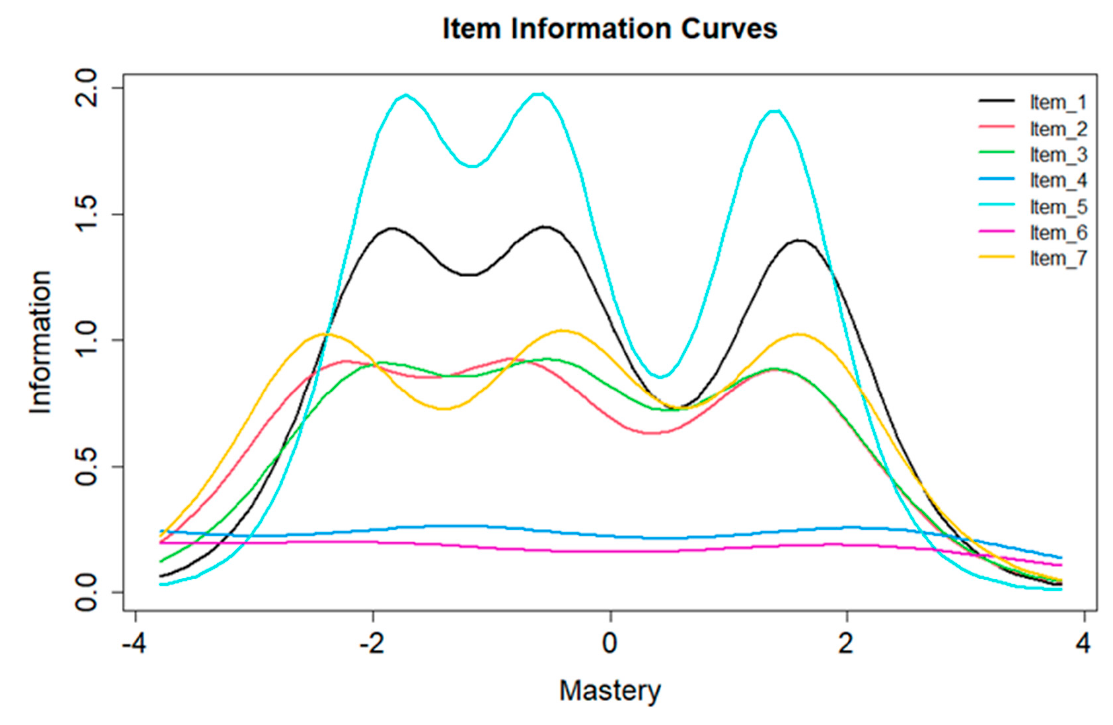
Figure 2. Item information curves for mastery items.